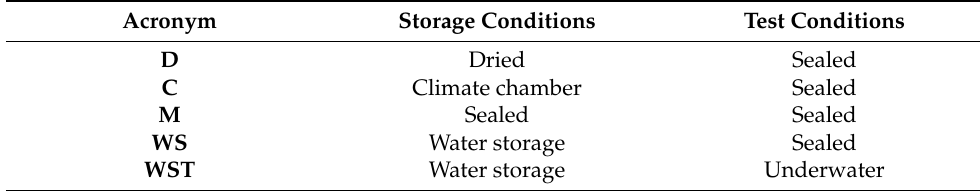
Table 2. Definition of the storage and test